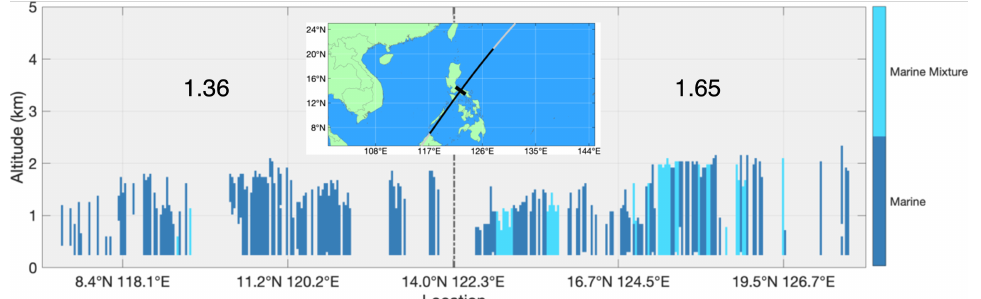
Figure 3. Effect of spectral depolarization ratios on the discernment between polluted marine and clean marine aerosol layers observed by CATS on 8 March 2015.